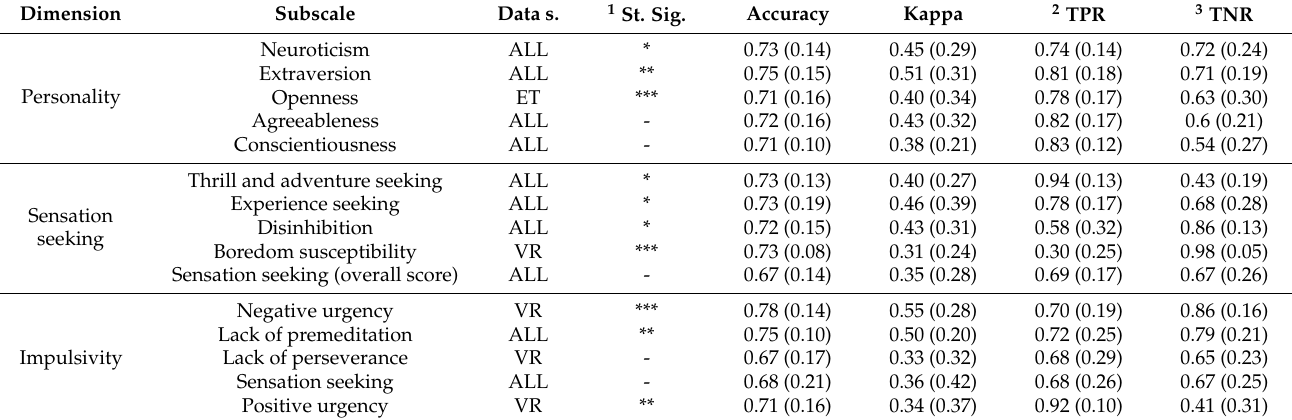
Table 4. Results of the models obtained with highest accuracy for every target